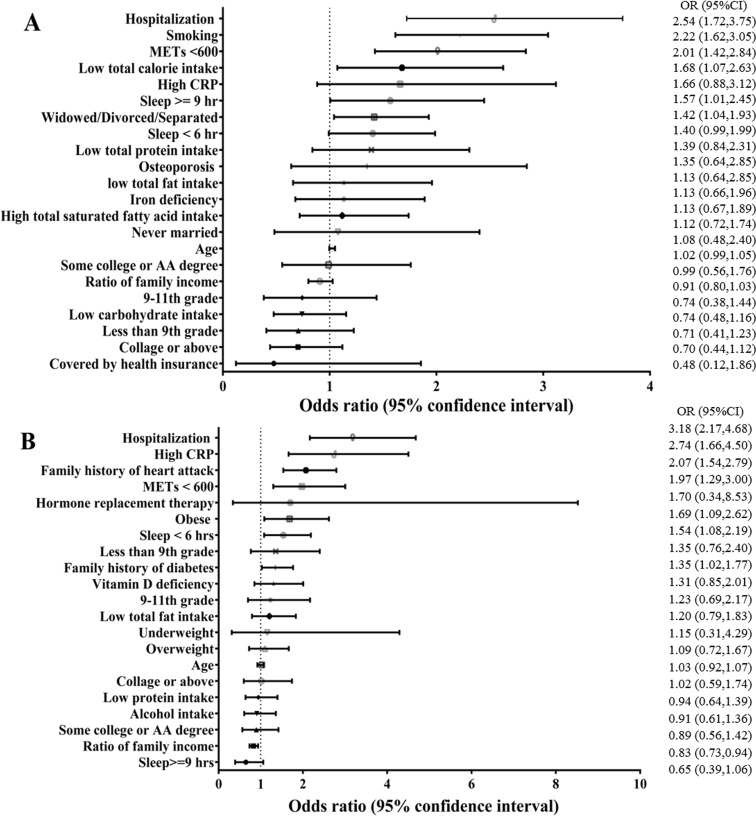
Risk factors for geriatric frailty: multivariable regression analysis in males (A) and females (B).